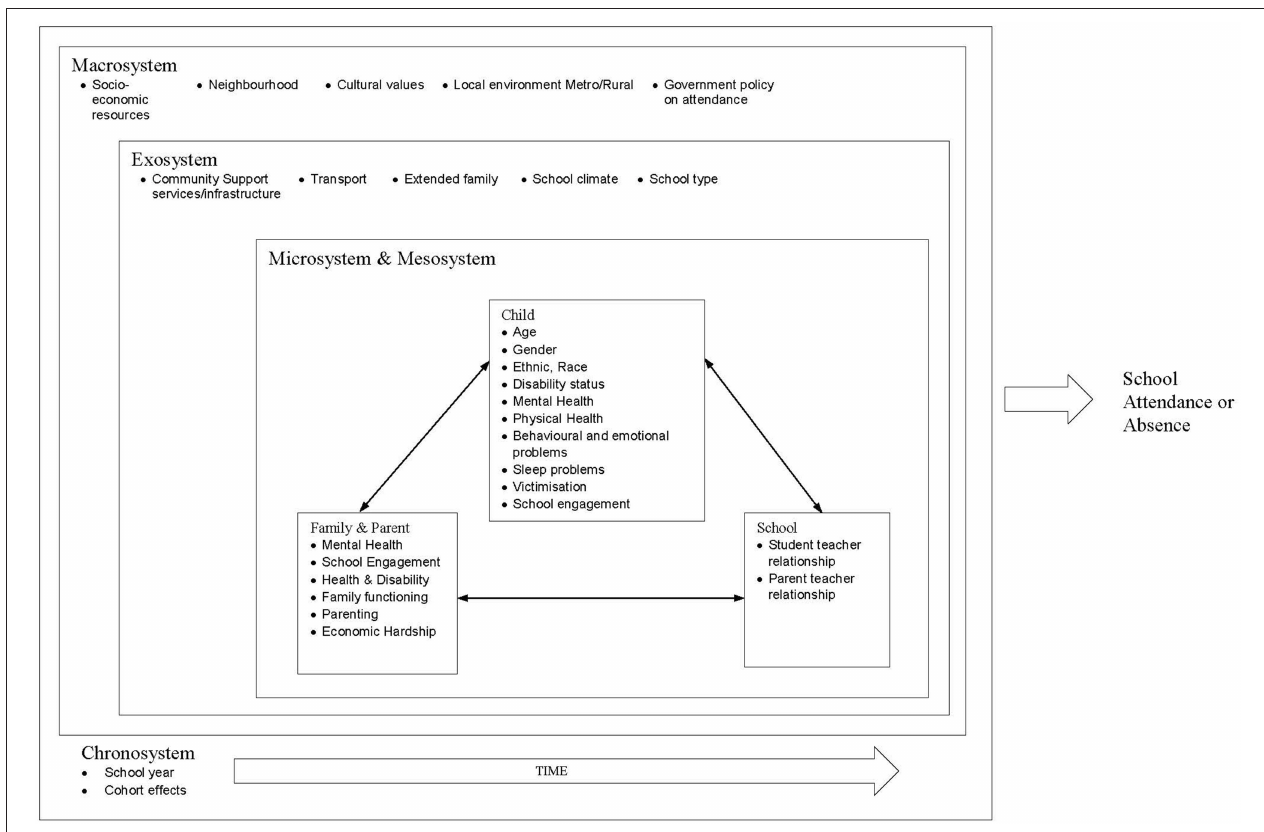
FIGURE 1 | The KiTeS bioecological systems framework for school attendance and